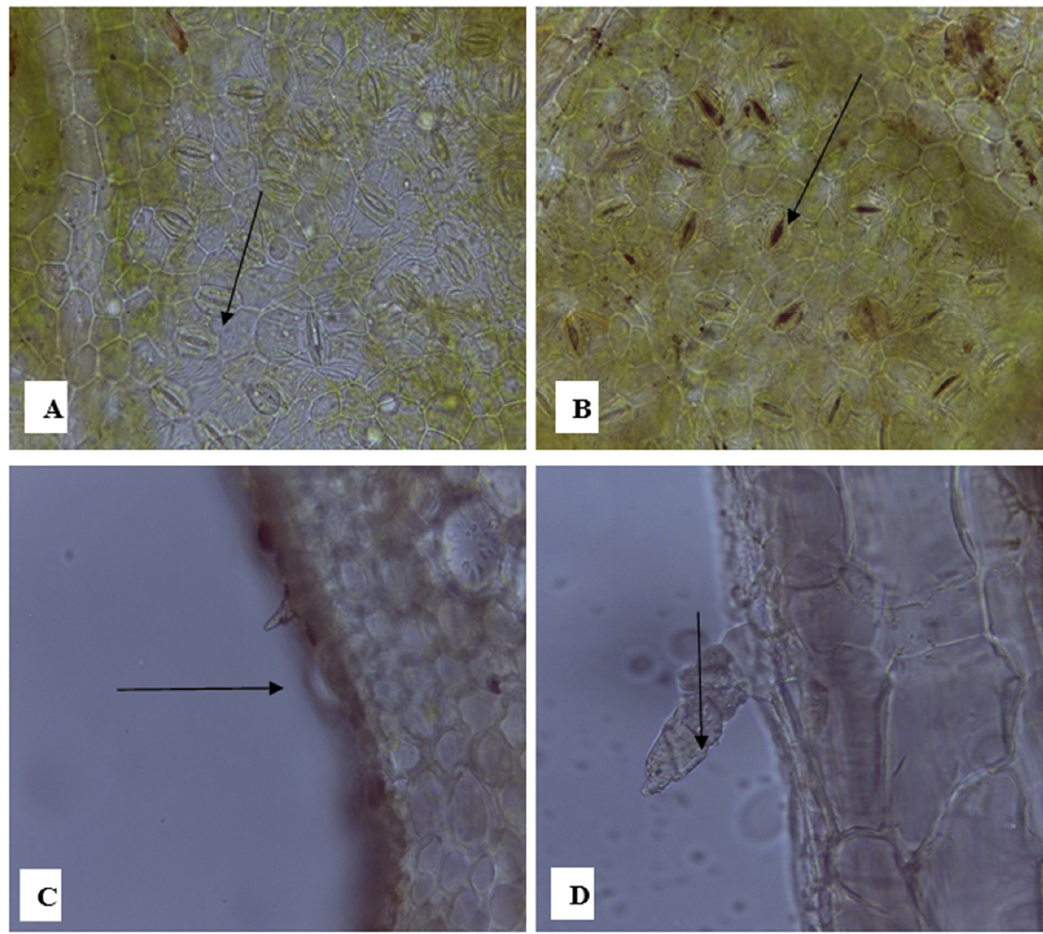
Plate 3. Photomicrographs of Ficus platyphylla leaves (A) Ficus platyphylla leaf sample from control showing normal stomata. (B) Ficus platyphylla leaf sample from arterial road site showing occluded stomata. (C) Ficus platyphylla leaf sample from the control site showing short trichomes. (D) Ficus platyphylla leaf sample from the arterial road site showing long trichomes. Magnification ×400 Polyalthia